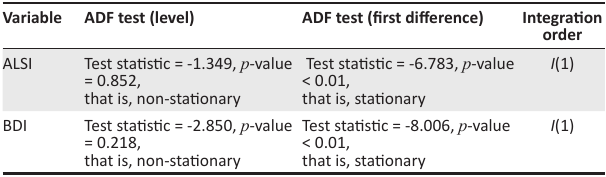
TABLE 1: Augmented Dickey–Fuller test results for level and first difference for both All Share Index and Baltic Dry Index time-series,